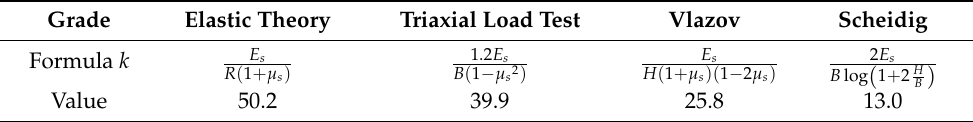
Table 1. The values of the foundation coefficient from different empirical formulas.